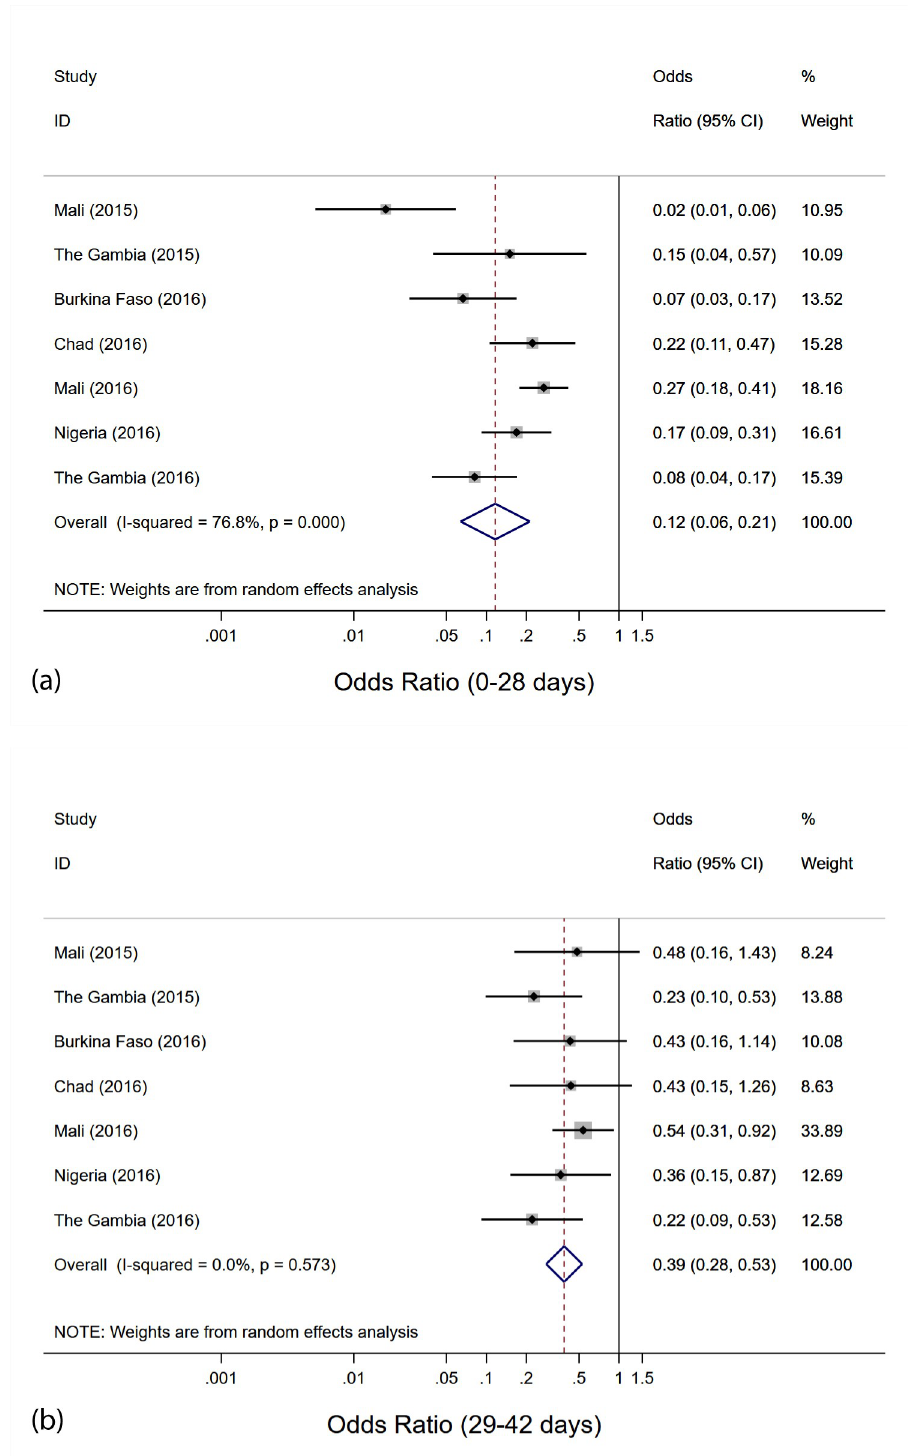
Fig 3. Meta-analysis of the odds ratio for seasonal malaria chemoprevention (SMC) within the previous 28 days and 29–42 days ago. (a) SMC within the previous 28 days; (b) SMC 29–42 days ago. Results from random-effects